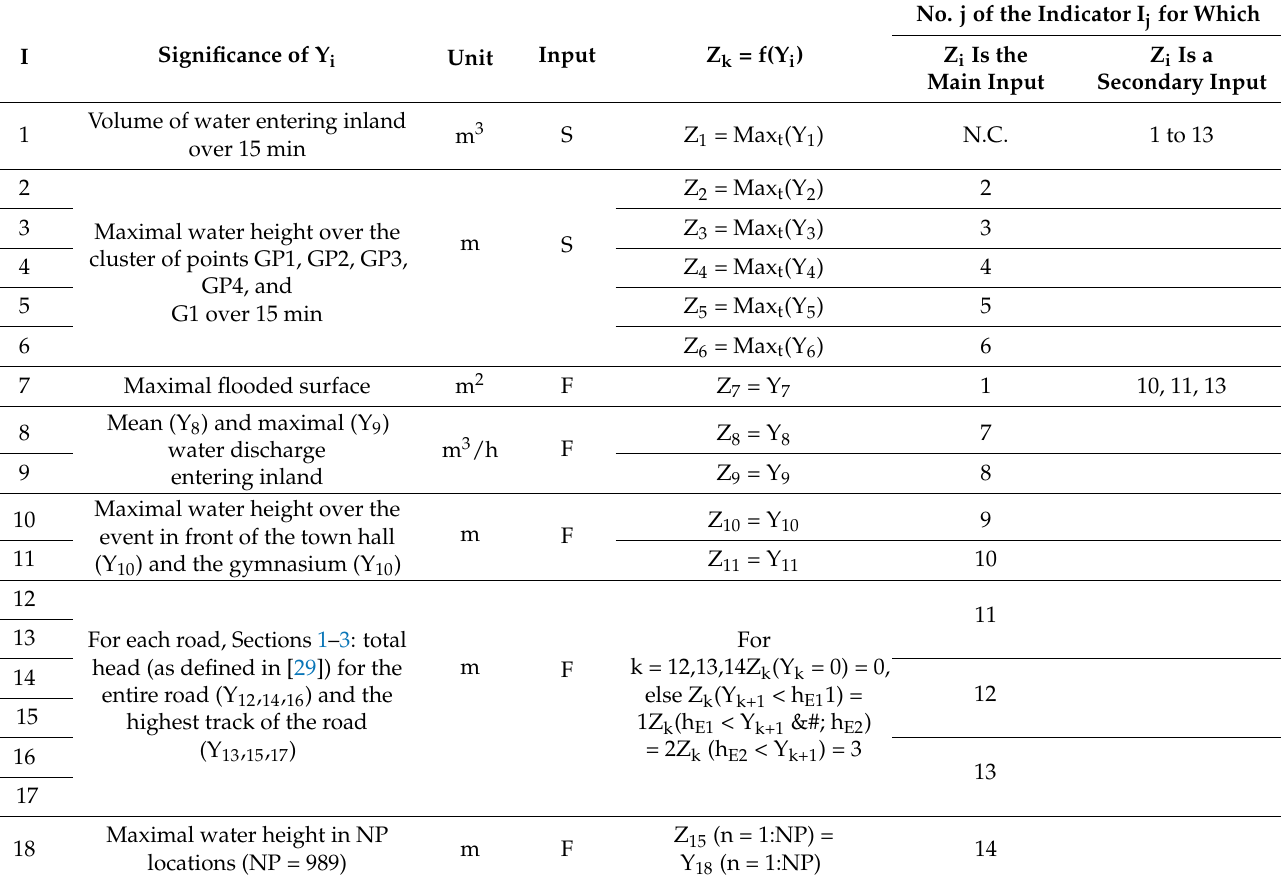
Table 2. Computed quantities Yi, intermediate variables Z k , and correspondence with the indicators I j . The input column indicates that the inputs of the metamodels are either scalar (S), i.e., steady, or functional (F), i.e.,